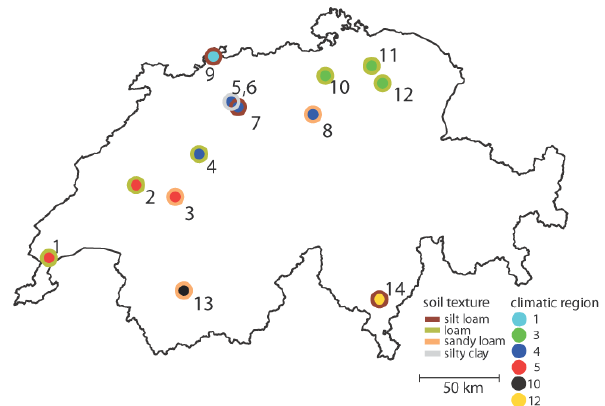
Fig. 1. Map of Switzerland showing the location, climatic re- gion, and soil texture (according to USDA taxonomy and aver- aged over 50cm depth) of the 14 investigated grassland sites of the SwissSMEX network. The indicated climate regions are based on the classification of M¨uller